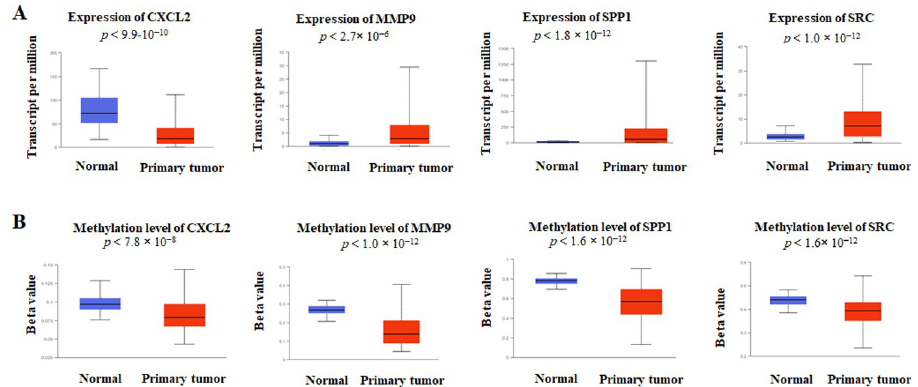
Fig 7. The expression and methylation status of hub genes in hepatocellular carcinoma ( n = 377) as compared to the normal controls ( n = 50) using TCGA samples. (A) Expression levels of CXCL2 , MMP9 , SPP1 and SRC using TCGA samples; (B) Promoter methylation levels of CXCL2 , MMP9 , SPP1 and SRC , respectively.